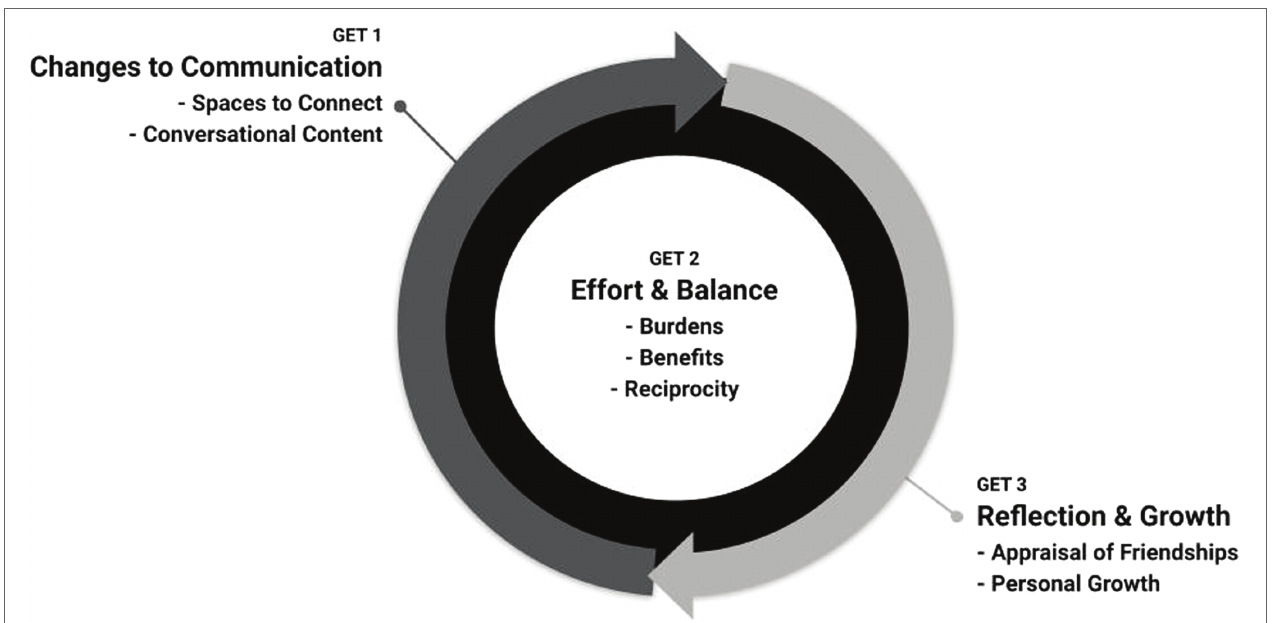
FIGURE 1 | Graphic simplifying the interaction and inter-relatedness of the three group experiential themes